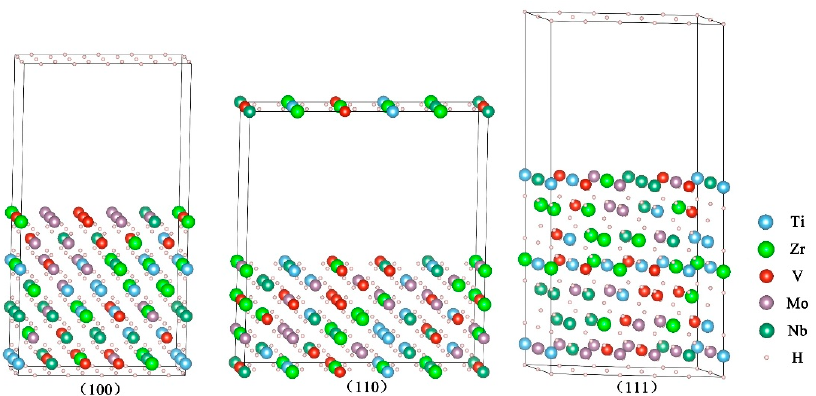
Figure 1. Schematic view of the geometrical structures for the (100), (110) and (111) surfaces of HEA TiZrVMoNb hydrides.